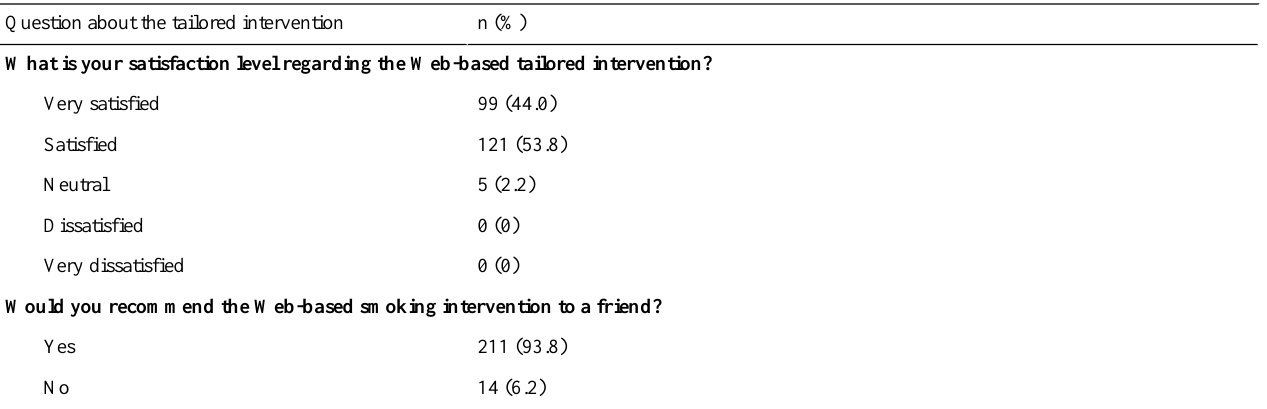
Table 3. Acceptability and satisfaction of the Web-based tailored intervention